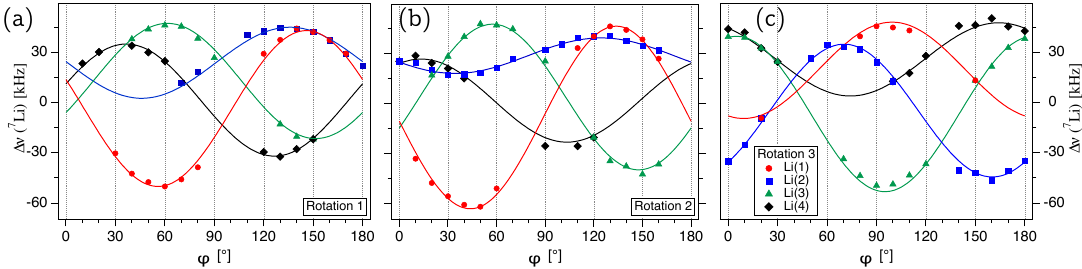
Figure 5. (a) Single crystal of aluminum nitride, AlN, from Leibniz Institute for Crystal Growth (IKZ, Figure 6. ( a ) Plot of the satellite splittings over 180 o for the four magnetically inequivalent 7 Li at Berlin), with the crystallographic c axis and ab plane indicated by arrows.[10] (b) Wurtzite structure Wyckoff position 4 a , acquired by rotating the LDP crystal counter-clockwise by 10 o around the three of AlN, according to Reference [9], viewed down the crystallographic (11-20) direction. The aluminum goniometer axes (cid:126) g 1 ( a ), (cid:126) g 2 ( b ), and (cid:126) g 3 ( c ). The lines represent the fit of the experimental points to the atoms (grey) and the nitrogen atoms (yellow), both located at Wyckoff position 2 b , are tetrahedrally quadrupole coupling tensor elements and axes orientation (see text for coordinated by each other with one Al-N bond directed parallel to the crystallographic c axis. (c) Individual, tetrahedrally coordinated, aluminum and nitrogen atom in the crystal structure of AlN, in which the three equal, shorter, bonds Al/N—I/II/III [1.8891(8) Å] and the longer bond Al/N—IV [1.9029(16) Å] along the three-fold rotation axis are highlighted. a Drawing generated with the Vesta program [11].